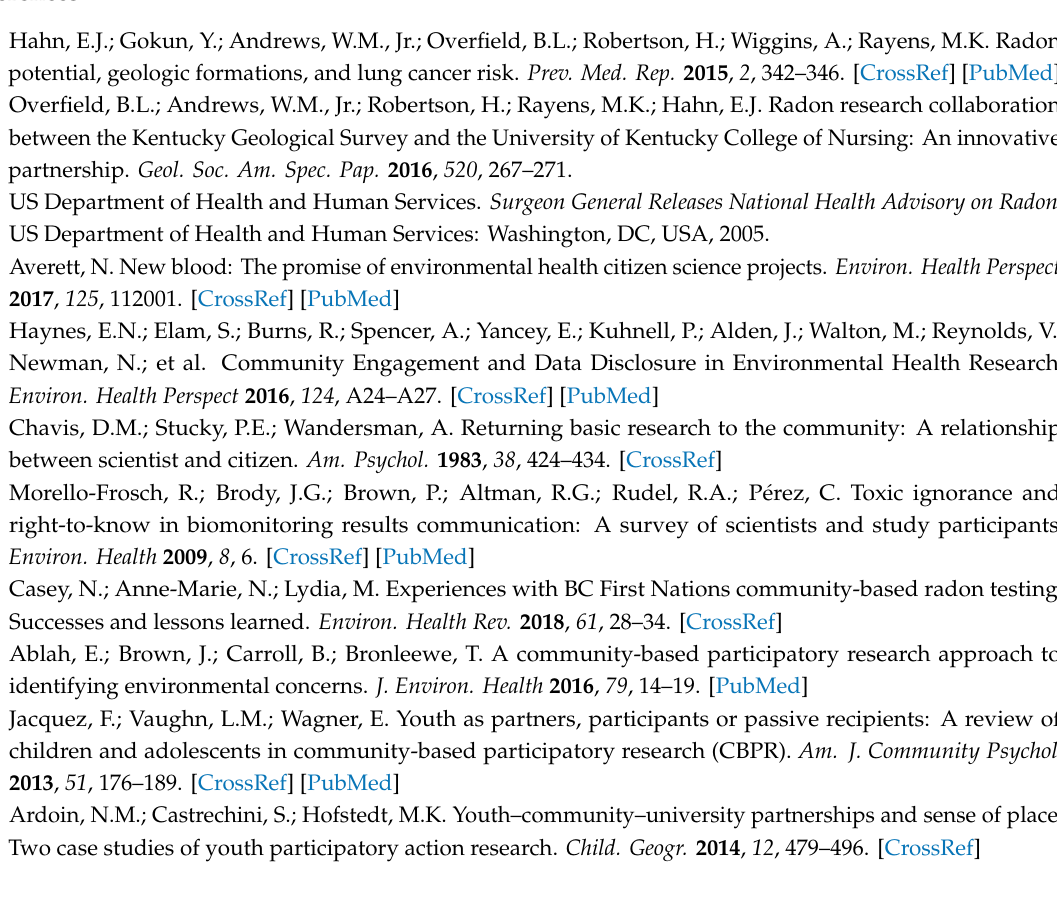
Figure S1: RAD7 Photo, Table S1: Indoor and Soil Gas Radon Levels Example Report Back, Booklet S1: Radon Test Kit